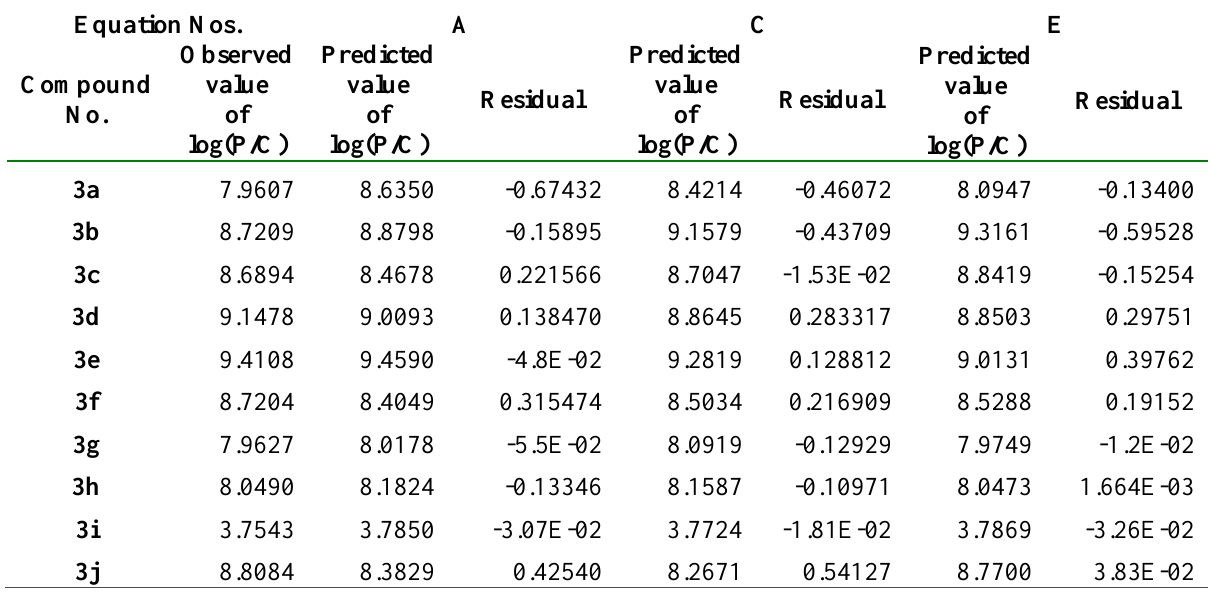
Table 5a. Compound-wise diagnostics values of regression analysis for Gram Negative bacteria. Equation Nos.